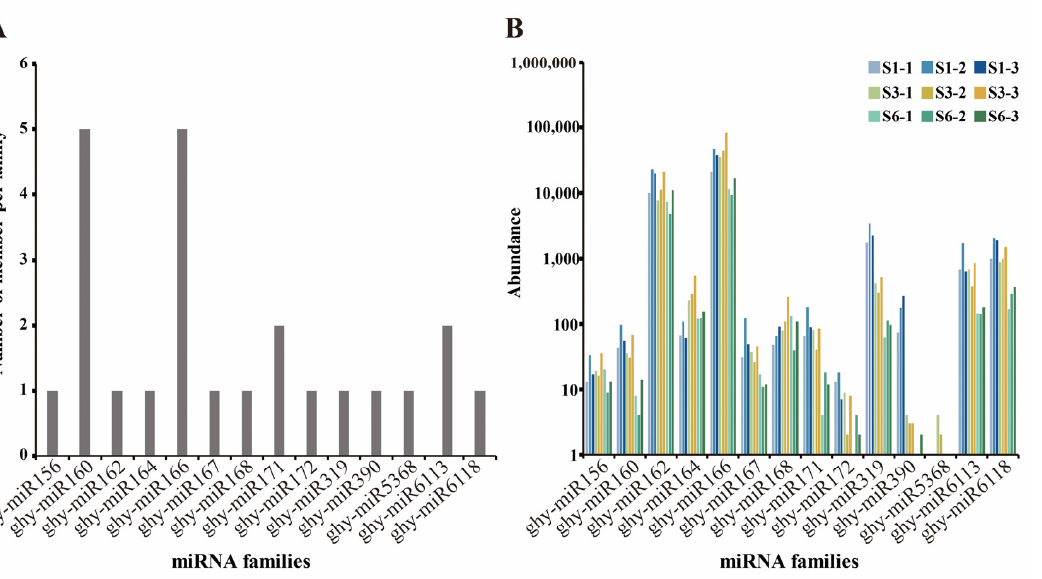
Figure 3. Identification of conserved miRNA families from gerbera. ( A ) Distribution of conserved miRNA family members. ( B ) Counts of each conserved miRNA family. S1, S3, and S6 represent ray petals at different stages, and the numbers after the hyphen represent different biological replicates.